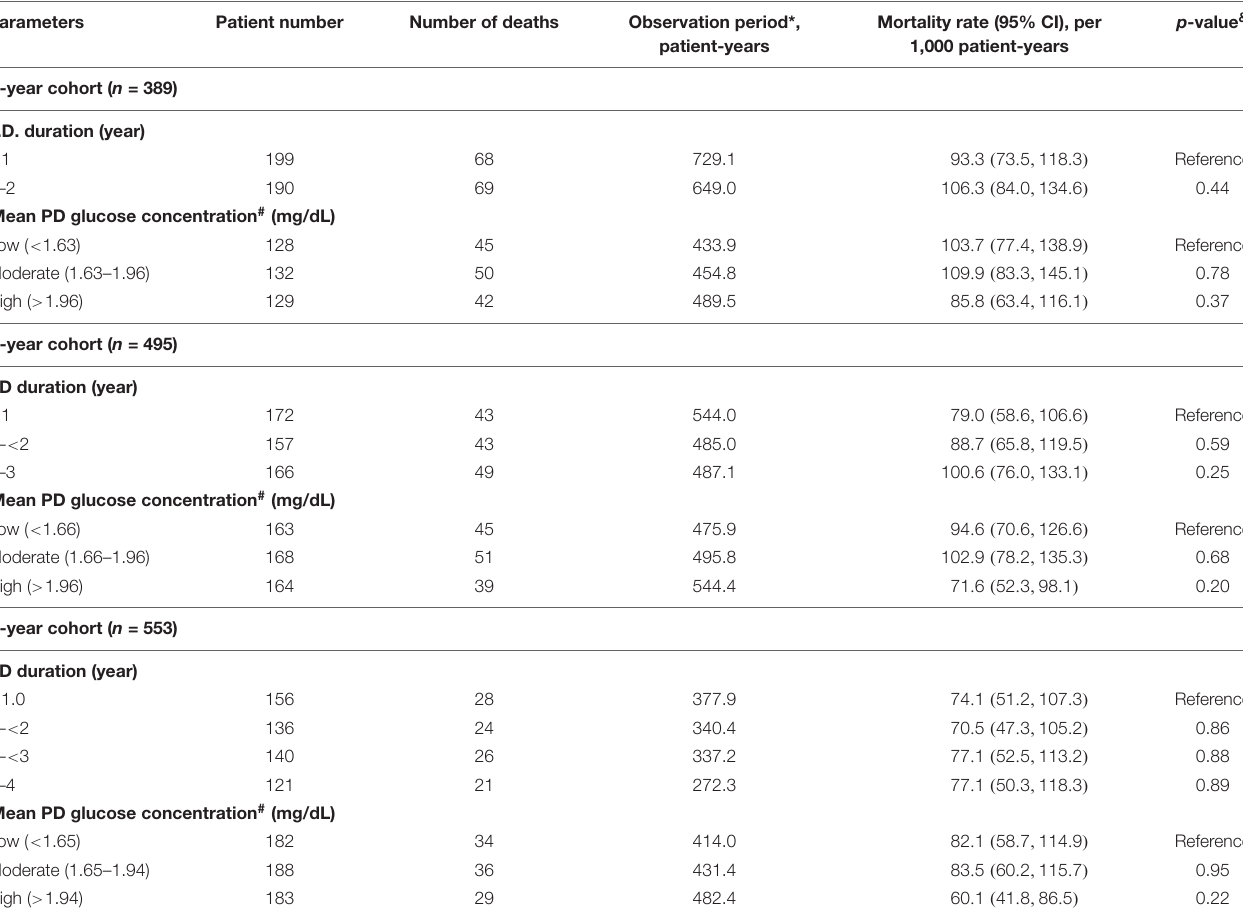
TABLE 2 | Death event number, observation period, and mortality concerning peritoneal dialysis exposure by different time-window cohort.